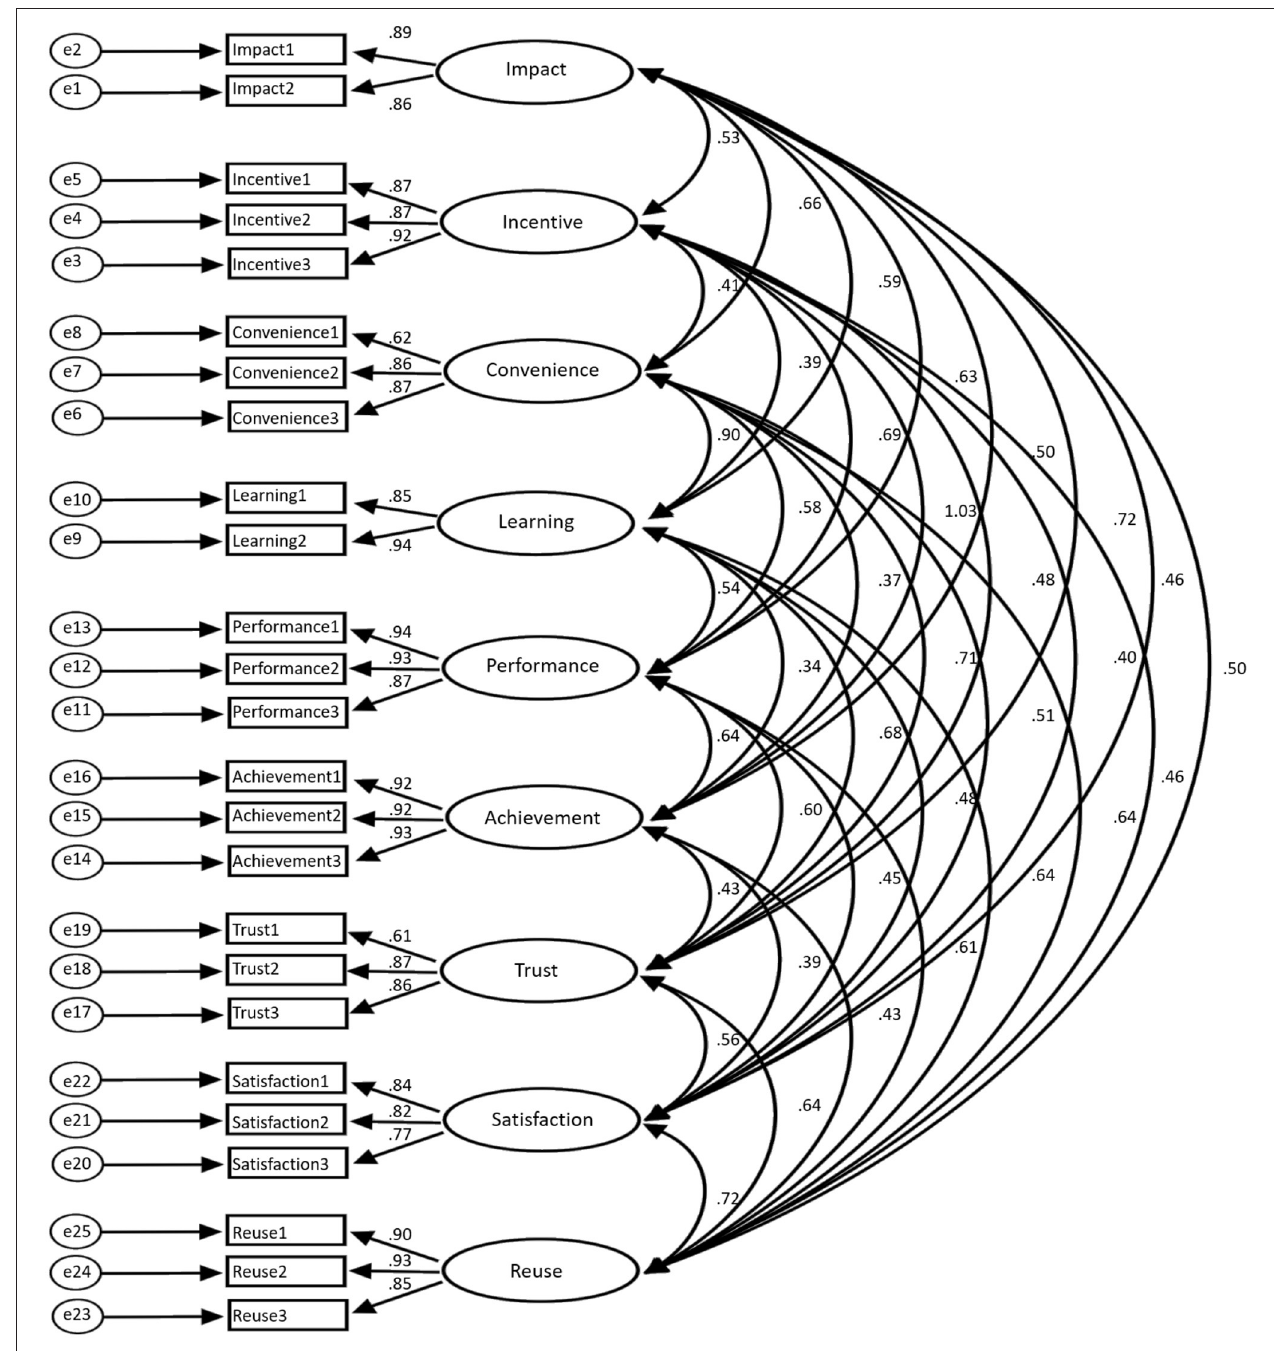
FIGURE 2 | Confirmatory factor analysis